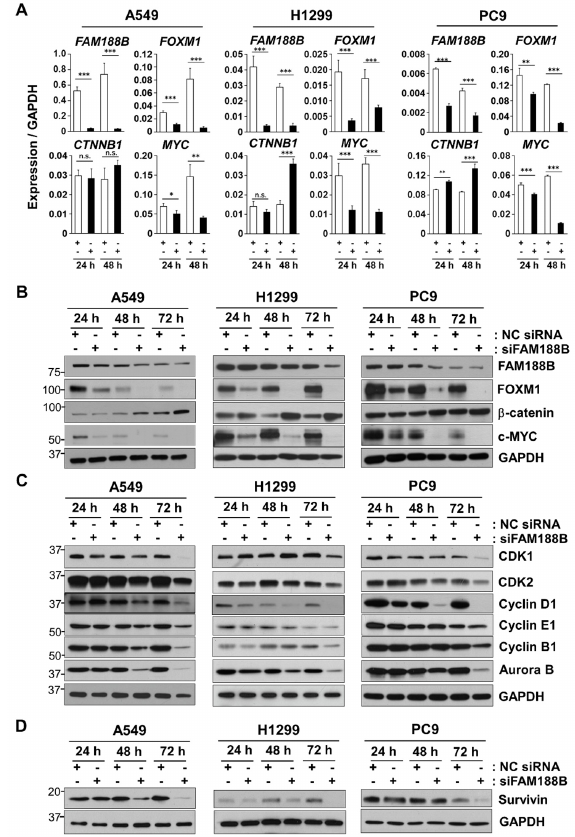
Figure 3. Effects of FAM188B knockdown on expression levels of oncogenic transcription factors, cell cycle-regulatory proteins and cell survival proteins ( A – D ) A549, H1299, and PC9 cells were transfected either with NC siRNA or siFAM188B for indicted times. Cells were then processed either for qPCR analysis of FAM188B , FOXM1 , CTNNB1 ( β -catenin gene), and c-MYC , ( A ) or for immunoblot analysis using indicated antibodies ( B – D ). GAPDH was used as a control for qPCR and immunoblot analysis. These experiments were conducted two times independently with comparable results. The levels of proteins were quantified by a densitometry and normalized to GAPDH (Figure S7). Error bars